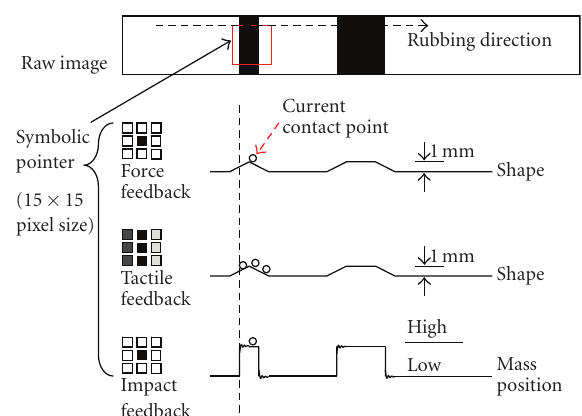
Figure 9: Methodology of texture display according to the stimula- tion